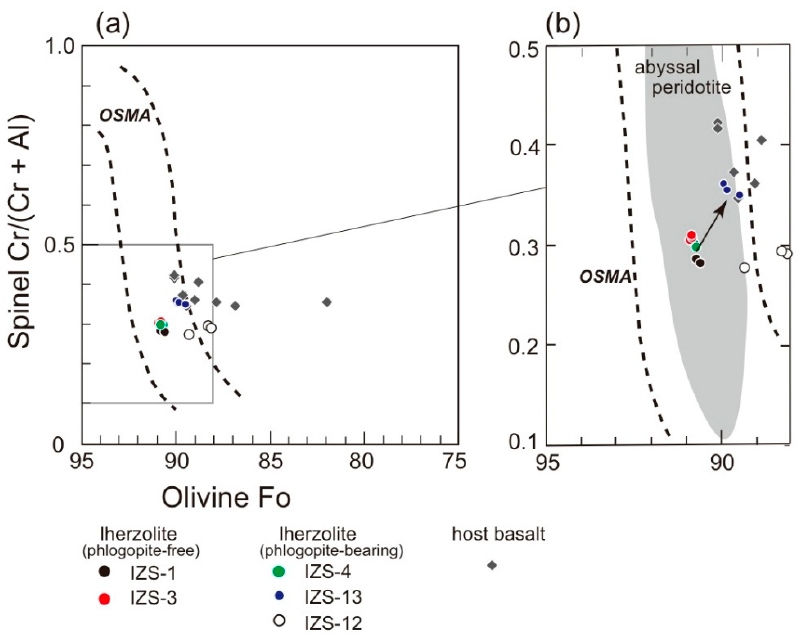
Figure 8. Fo (olivine)-Cr# (chromian spinel) relations. The main part of ( a ) is enlarged as ( b ). The field between the broken lines is the olivine–spinel mantle array (OSMA) [41]. The field of abyssal peridotites is after Arai [41]. Note that olivine has been altered in one of our samples (IZS-06). The arrow indicates a possible metasomatic trend. Note that the phlogopite-free lherzolite is very confined on the Fo(olivine)-Cr# (spinel) space.